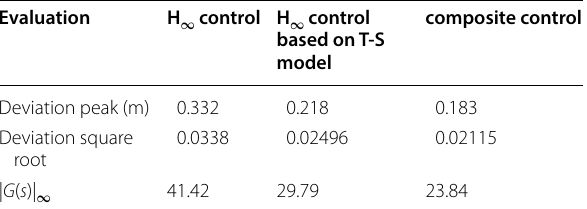
Table 5 Results of lateral deviation and performance